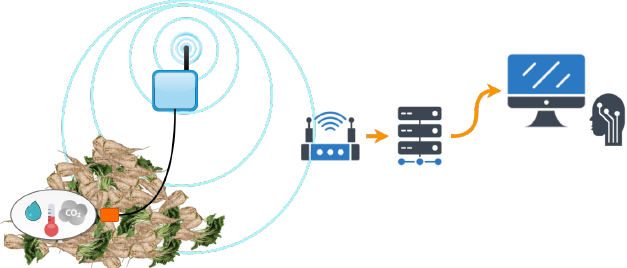
Fig. 1. Information flow from the sensor to the application server